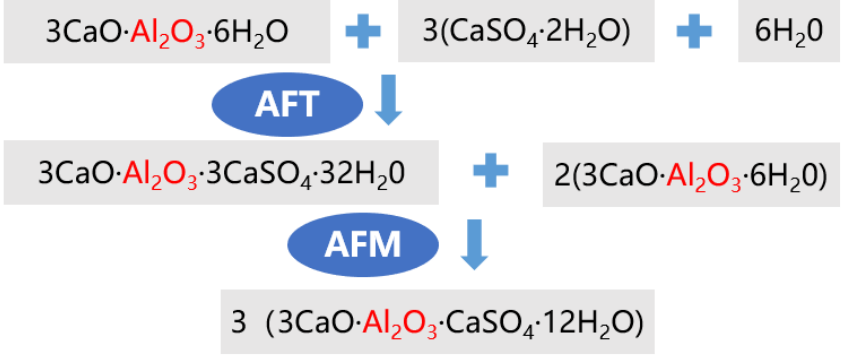
Figure 15. Reaction formula of AFT and AFM.